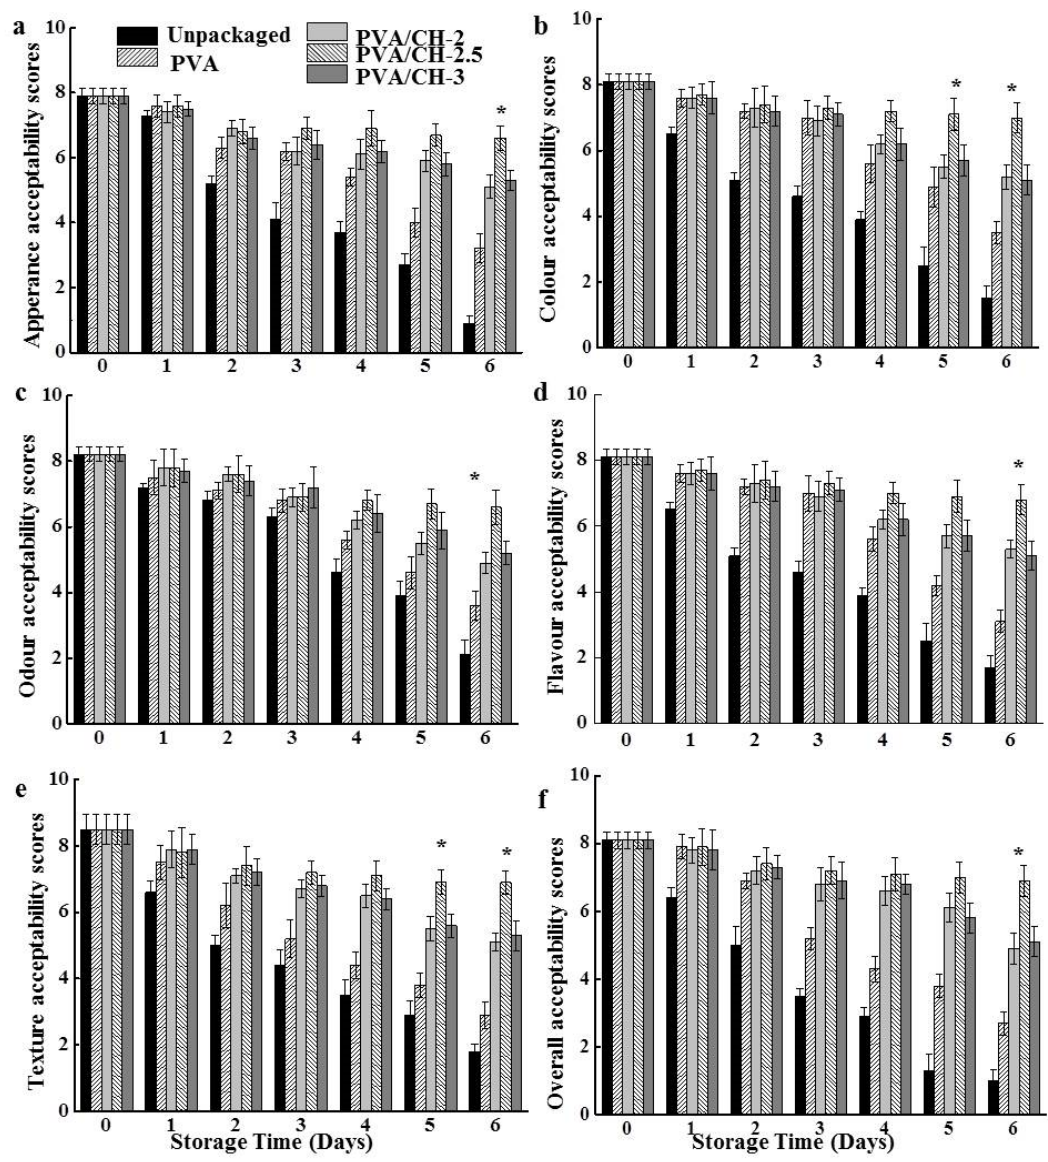
Figure 4. The sensory scores of ( a ) appearance acceptability; ( b ) color acceptability; ( c ) odor acceptability; ( d ) flavor acceptability; ( e ) texture acceptability and ( f ) overall acceptability of strawberries during storage times.